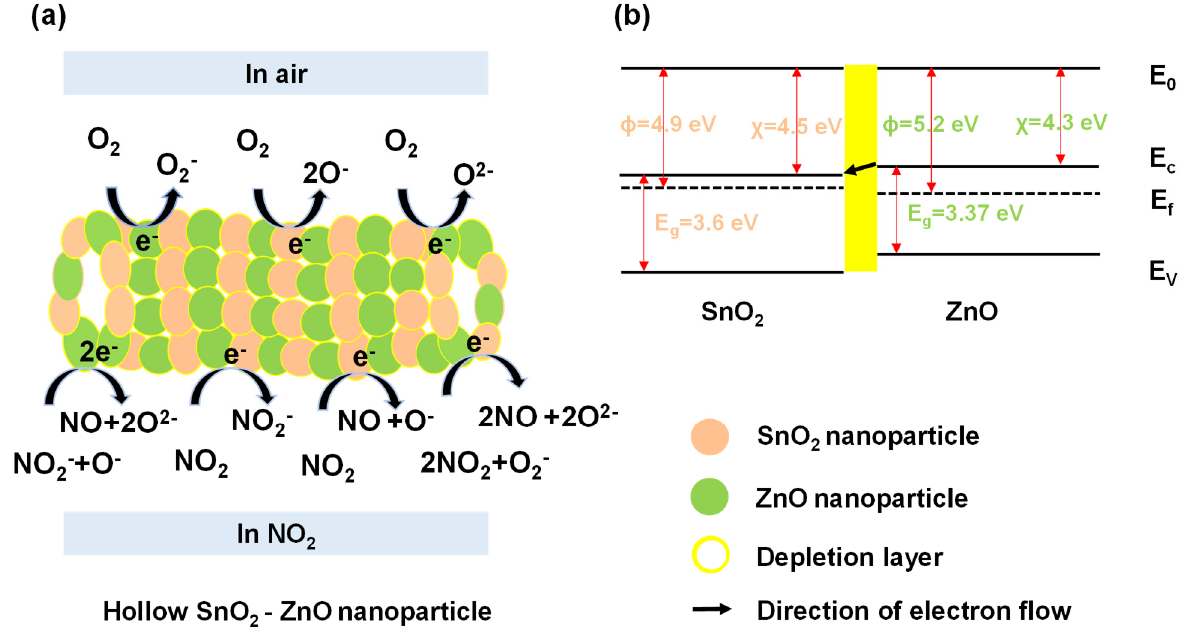
Figure 9. ( a ) Surface topography model of SnO 2 /ZnO composite nanofibers. ( b ) Energy band structure of SnO 2 /ZnO composite nanofibers.